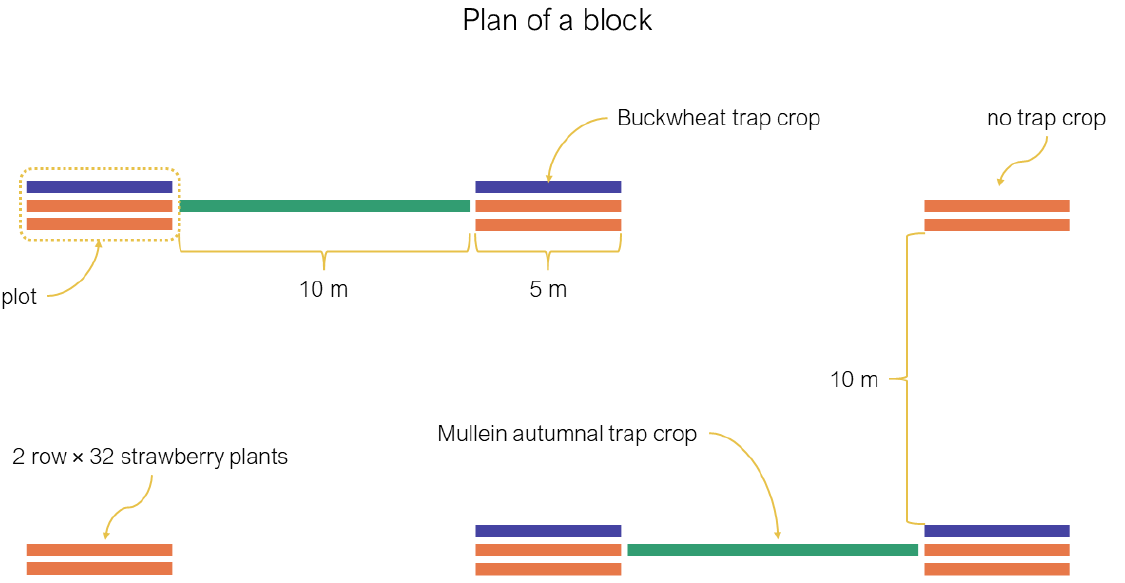
Figure 1. Experimental design plan of a typical block.